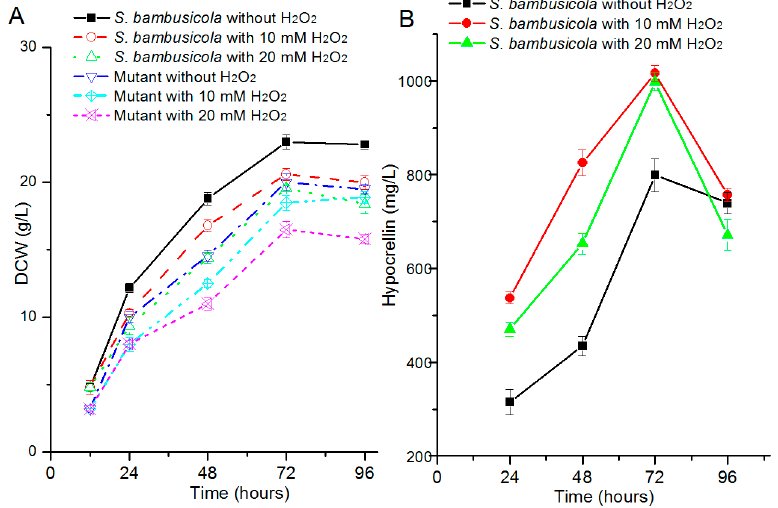
Figure 2. ( A ) Effects of H 2 O 2 addition (0, 10, and 20 mM) on dry cell weight (DCW) of S. bambusicola and a hypocrellin-deficient mutant; ( B ) Effects of different concentrates of H 2 O 2 on